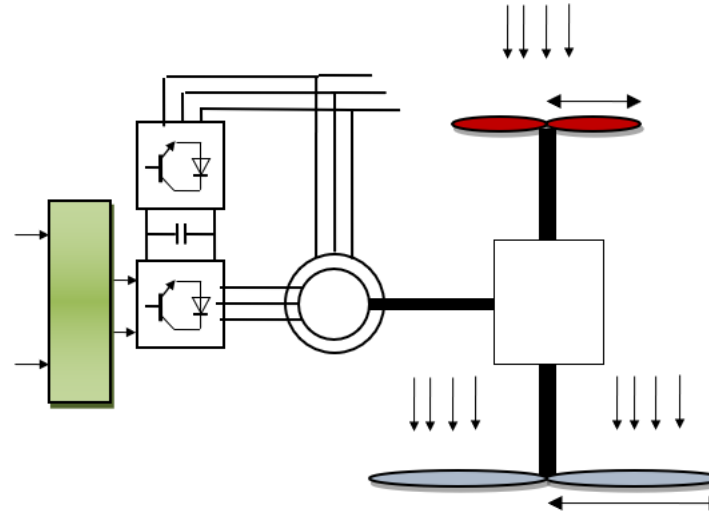
Figure 1. Block diagram of DRWP system with an induction generator.